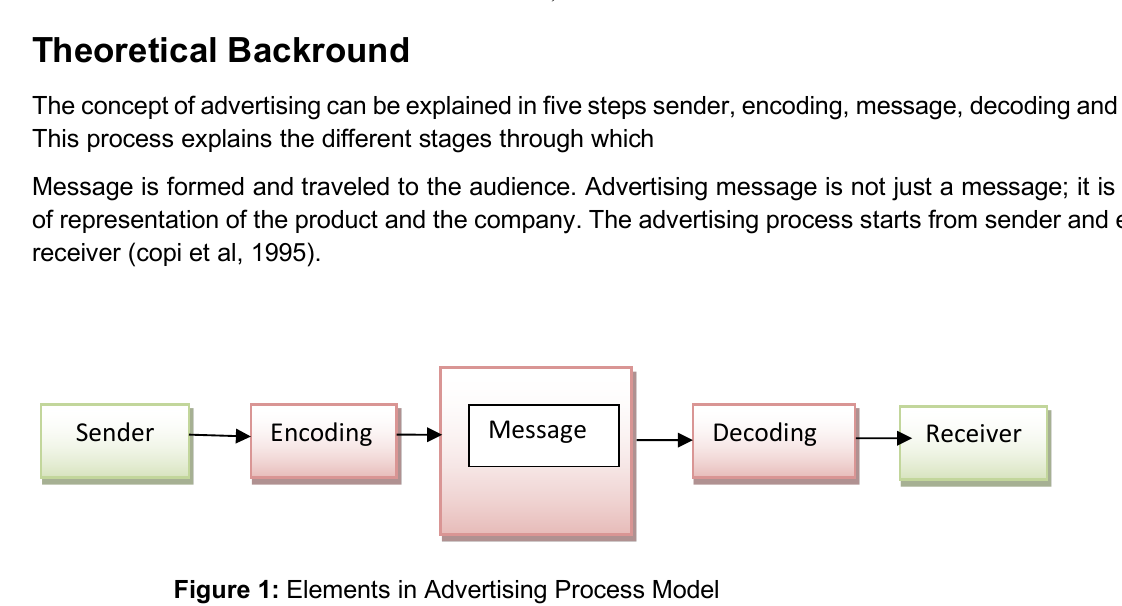
Figure 1: Elements in Advertising Process